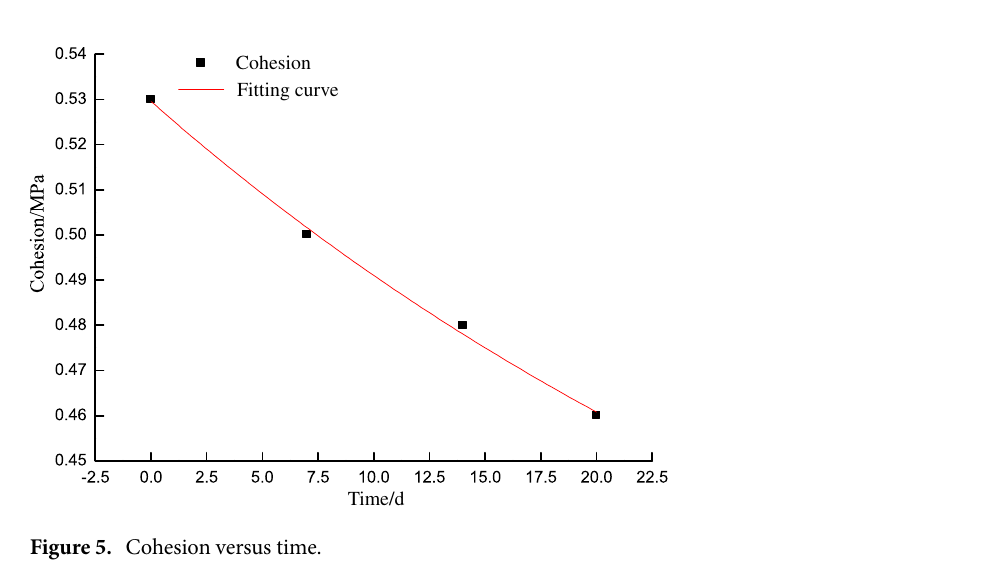
Figure 5. Cohesion versus time.